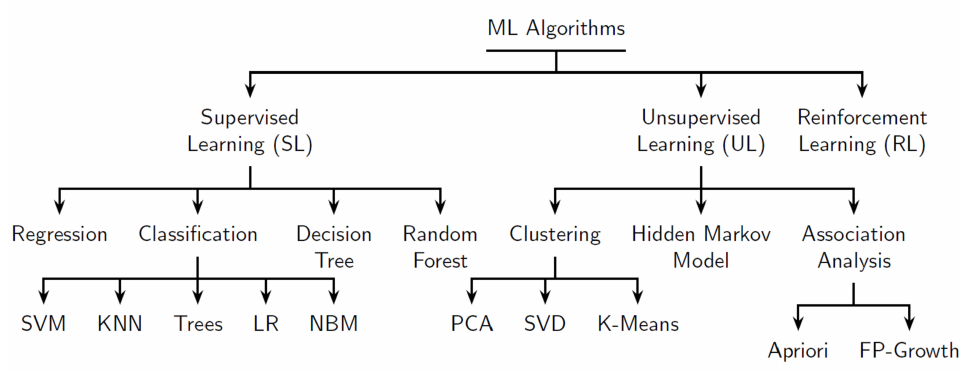
Figure 21. Machine learning (ML) algorithms’ acronyms: support vector machines (SVM), K-nearest neighbors (KNN), logistic regression (LR), Naïve Bayes multinomial (NBM), principle component analysis (PCA), singular value decomposition (SVD), frequent pattern-growth